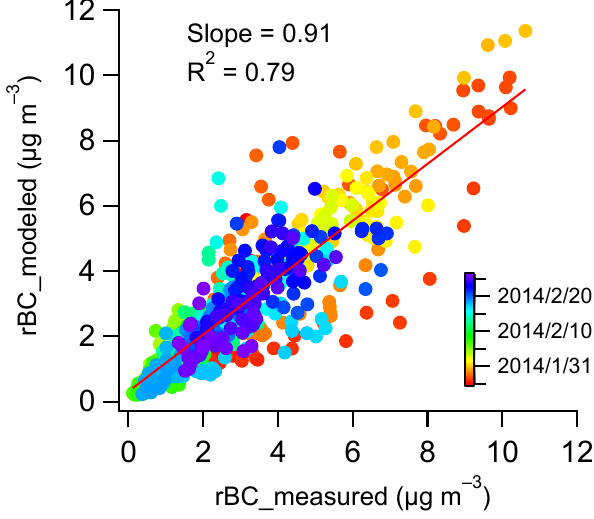
Figure 7. Linear fit between measured and modeled rBC. Table 1. The tri-linear regression results for the rBC-ACSM-PMF attribution.